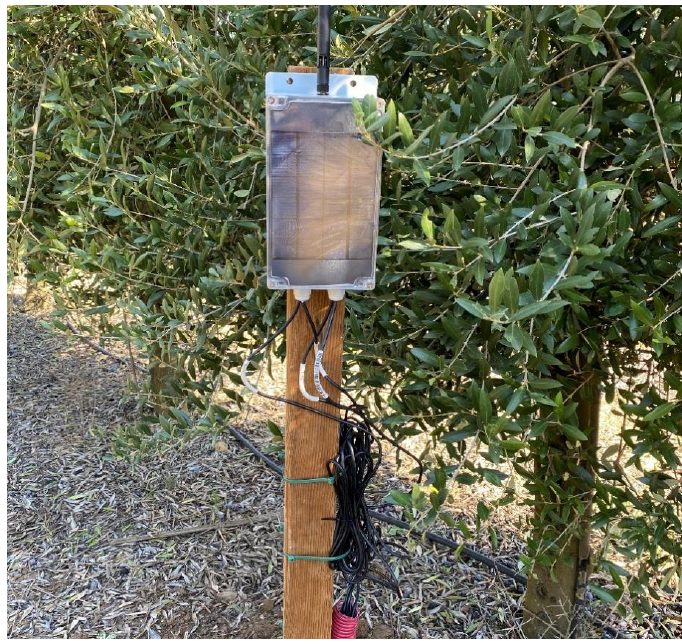
Figure 8. Communication node with connected soil moisture sensors.